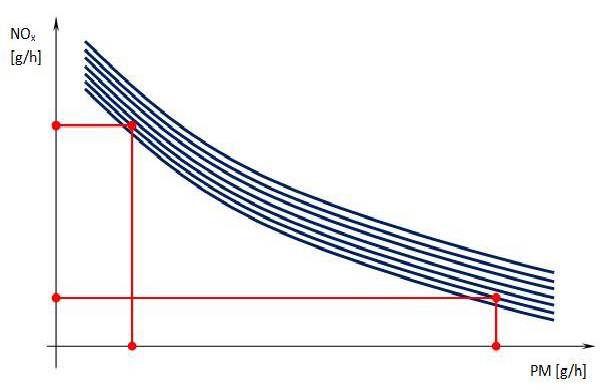
Fig. 2. Diagram of correlation between NO x and PM